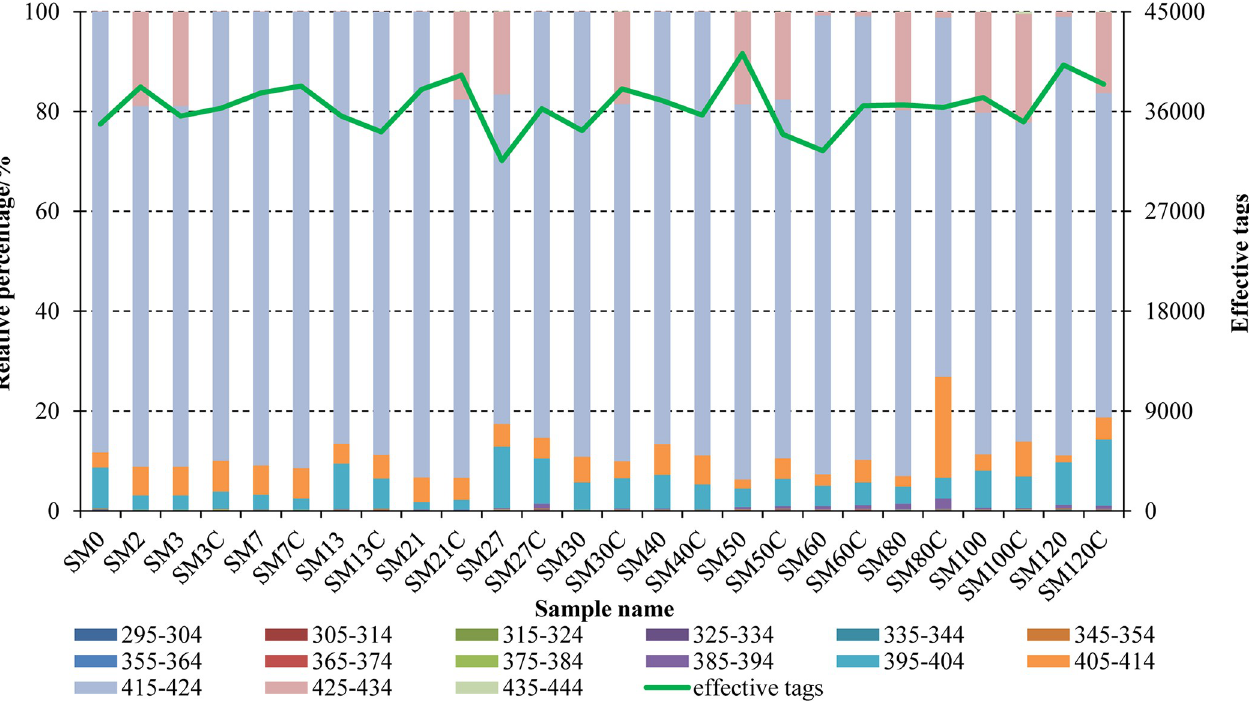
Fig 2. Length distributions of effective tags in different samples. For each sample, we calculated the average based on five replicates in the same distribution range. SM0 and SM2 represent fertilized eggs and turbot larvae on day 2, respectively. SM3, SM7, SM13, ... , SM100, and SM120 represent turbot larval intestinal tract samples on days 3, 7, 13, ... , 100, and 120 in the experimental group, respectively. Similarly, SM3C, SM7C, SM13C, ... , SM100C, and SM120C represent turbot larval intestinal tract samples on days 3, 7, 13, ... , 100, and 120 in the control group, respectively.